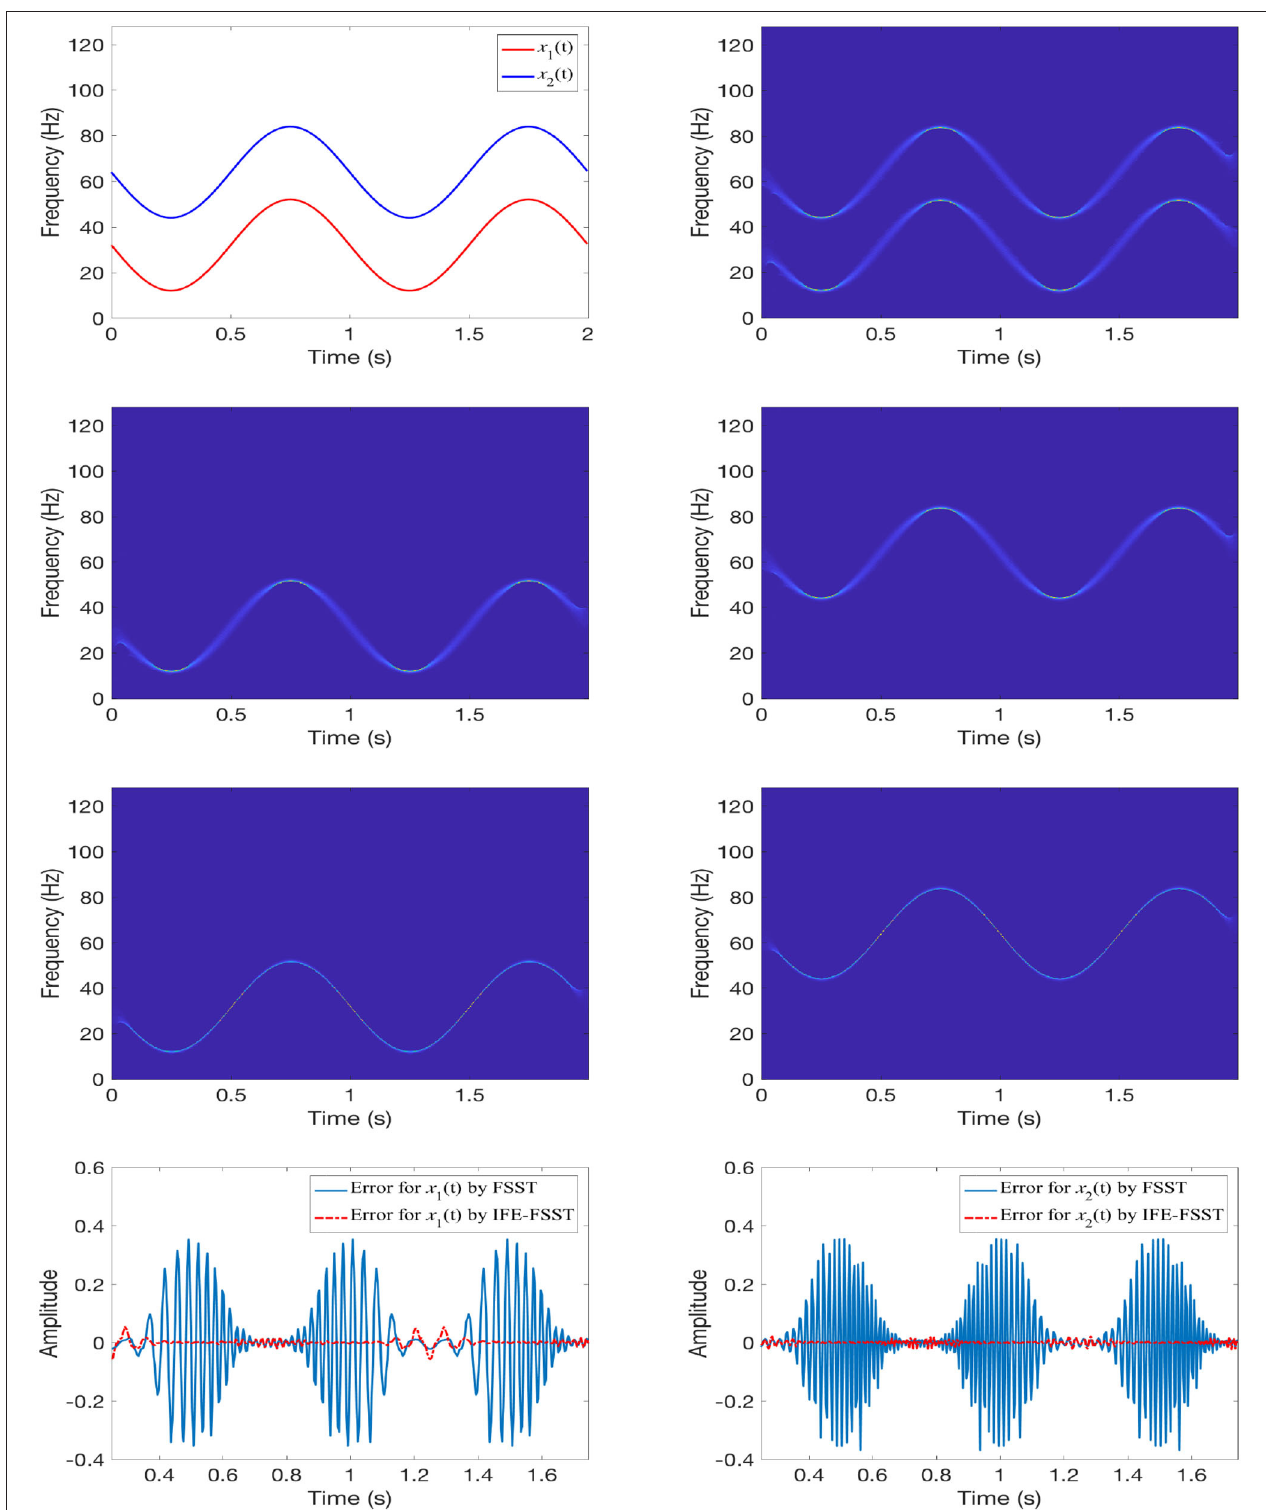
R x ( t , η ) (right) ; 2nd row: FSST for x 1 ( t ) (left) and FSST for x 2 ( t ) (right) ; 3rd row: | |